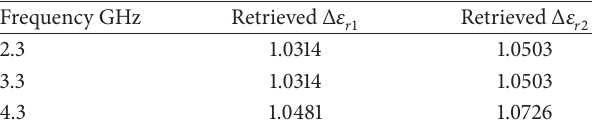
Table 3: Permittivity variation for each carrier